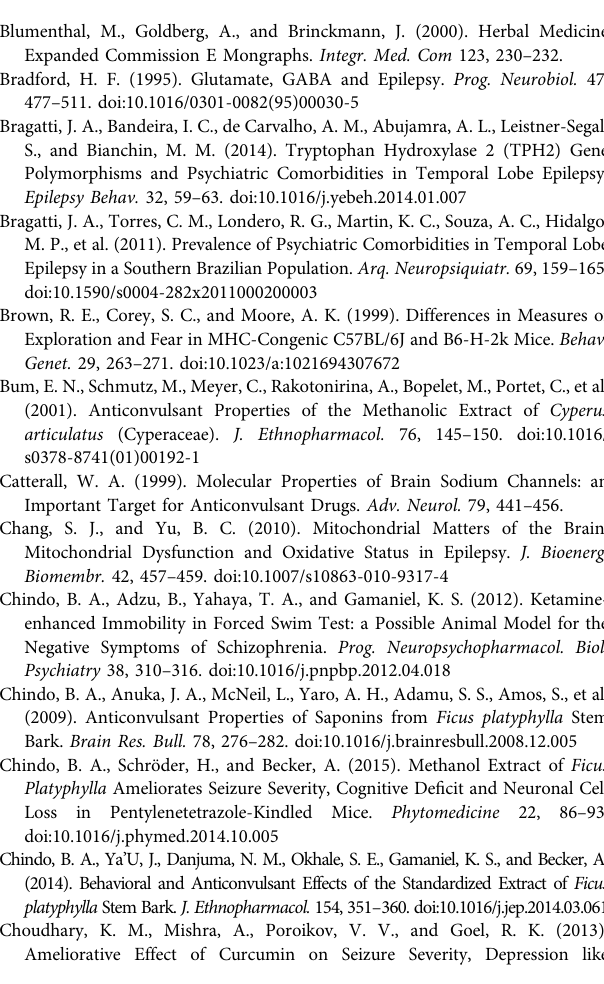
Supplementary Figure S1 | GC-MS total ion chromatogram of the Melissa of fi cinalis essential oil, with chromatography performed on a 30 m × 0.25 mm ID × 0.25 µm DB-5MS